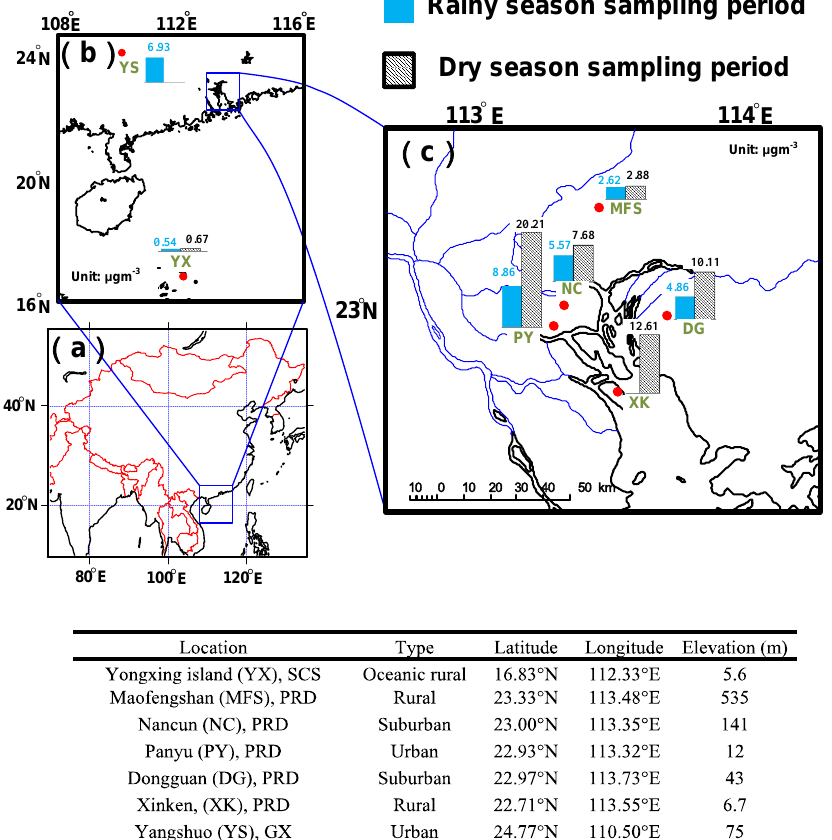
Fig. 1. Average black carbon concentrations during rainy and dry season sampling periods across different sampling sites in column plots on the map (column plots in different maps are on the same scale and the unit of the associated numbers is µgm − 3 ). The table in the figure summarizes characteristics of the sampling sites in this study. (a) Location of the study region in China. (b) Location of the two short-term sites: oceanic site at Yongxing island (YX) and the urban site Yangshuo (YS). (c) Location of the long-term sites in the Pearl River delta, including Maofengshan (MFS), Nancun (NC), Panyu (PY), Dongguan (DG), and Xinken(XK).